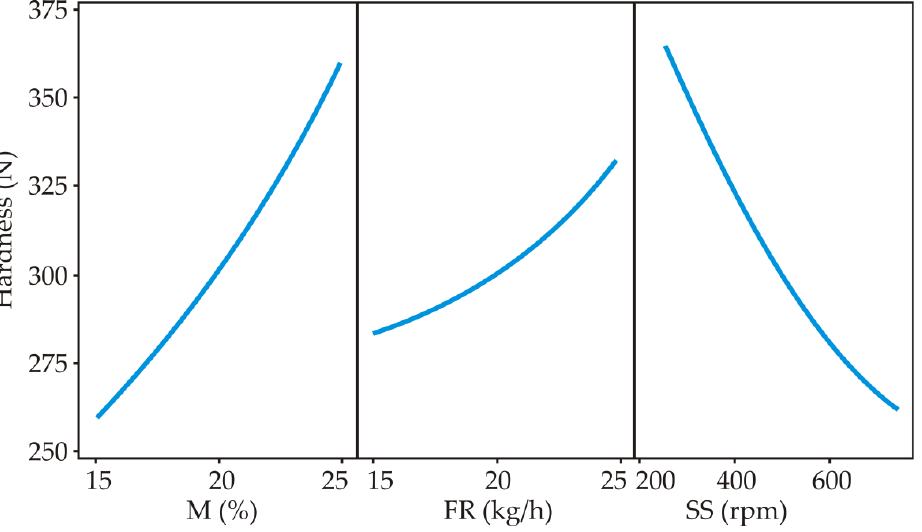
Figure 1. Influence of process parameters moisture (M), feed rate (FR) and screw speed (SS) on hardness .